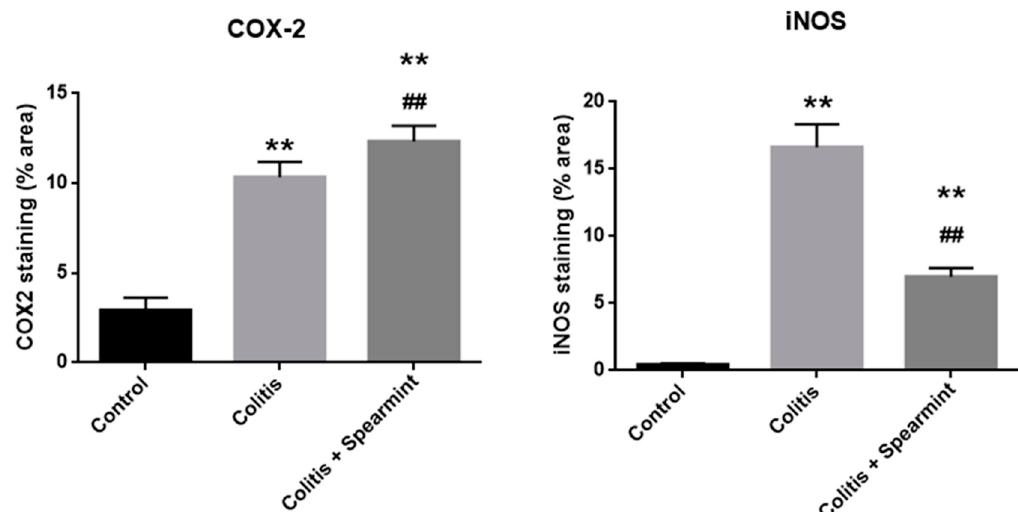
Figure 10. Effect of spearmint phenolic extract administration on the colon tissue expression of COX- 2 and iNOS. The production of COX-2 and iNOS staining were quantified. ** p < 0.01 vs Control; ## p < 0.01 vs Colitis.